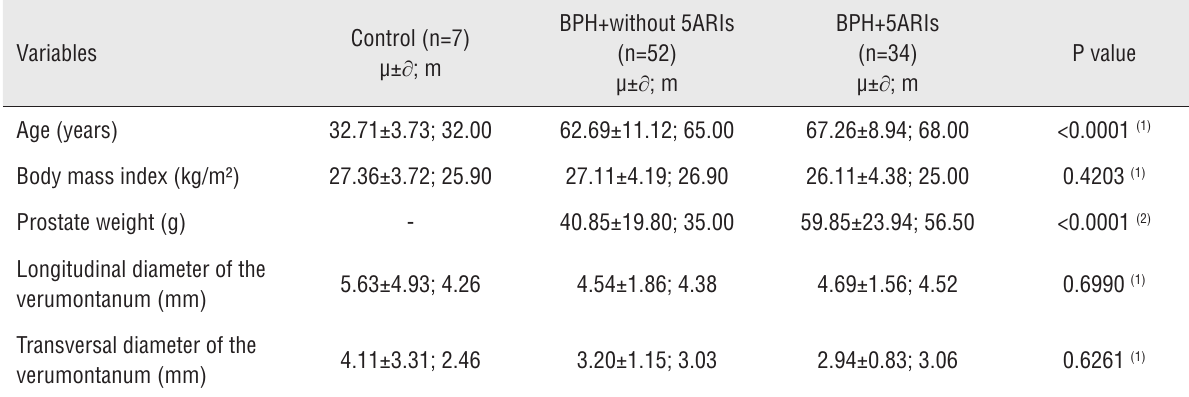
Table 2 - Clinical characteristics of the studied